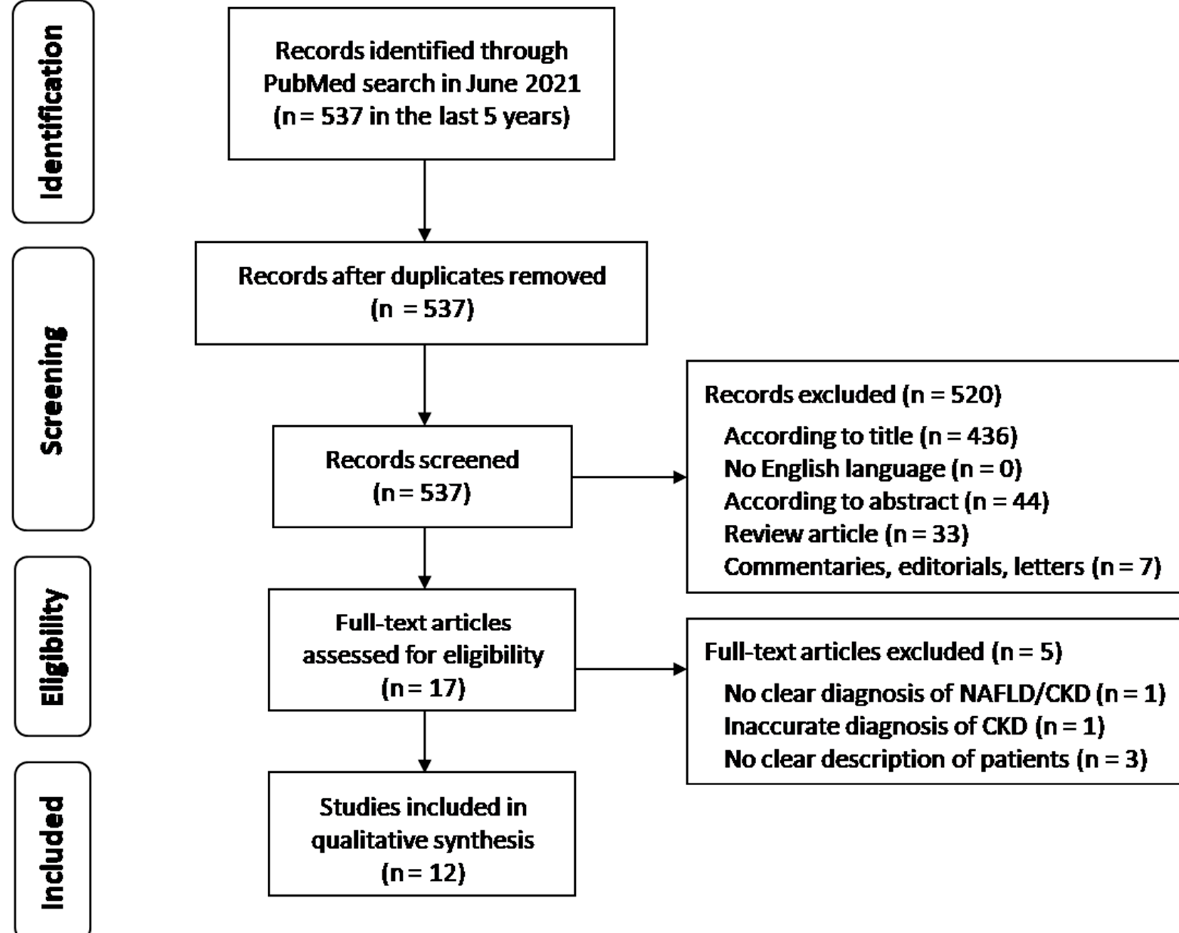
Figure 1. Flow chart of the search for relevant studies . NAFLD; nonalcoholic fatty liver disease, CKD; chronic kidney disease.